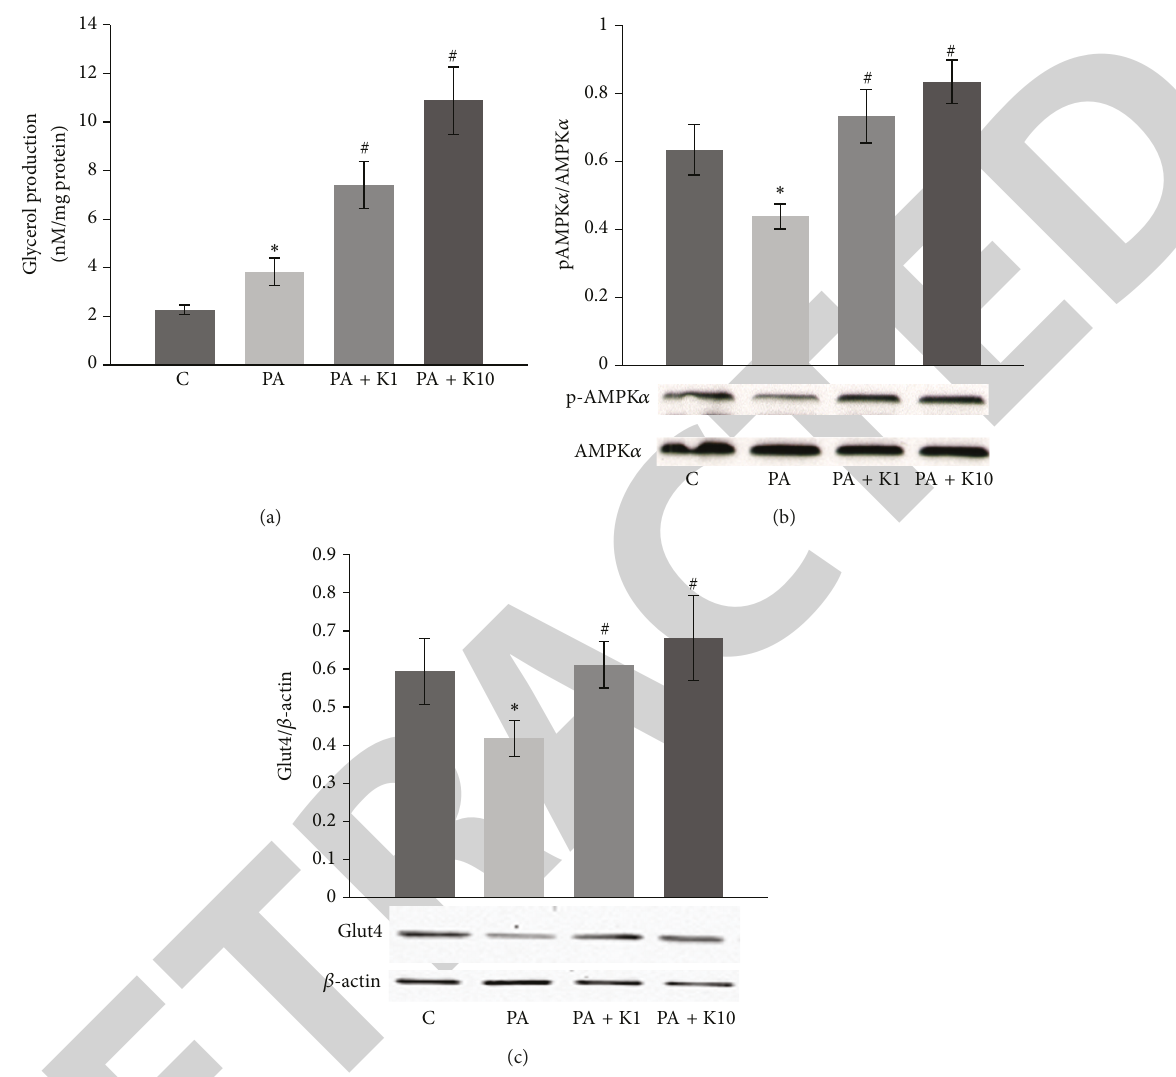
Figure 5: Kaempferol promoted lipolysis and reversed high glucose and fatty acid-impaired AMPK activity and Glut4 expression in muscle cells. C2C12 muscle cells were pretreated with vehicle (C: DMSO) or kaempferol (K1: 1 𝜇 M; K2: 10 𝜇 M) for 24h and then incubated in the presence or absence of 20 mM glucose and 0.5 mM palmitate (PA) for another 24 h. (a) Glycerol released into the medium was measured after 24h. (b) The phosphorylation of AMPK 𝛼 (p-AMPK 𝛼 ) in whole cell lysates was measured by immunoblotting and normalized to total AMPK 𝛼 . (c) Glut4 protein expression in the cell lysates was detected and normalized to 𝛽 -actin content. Data are means ± SE ( 𝑛 = 3 ). ∗ 𝑝 < 0.05 versus vehicle alone (C)-treated cells; # 𝑝 < 0.05 versus PA alone-treated